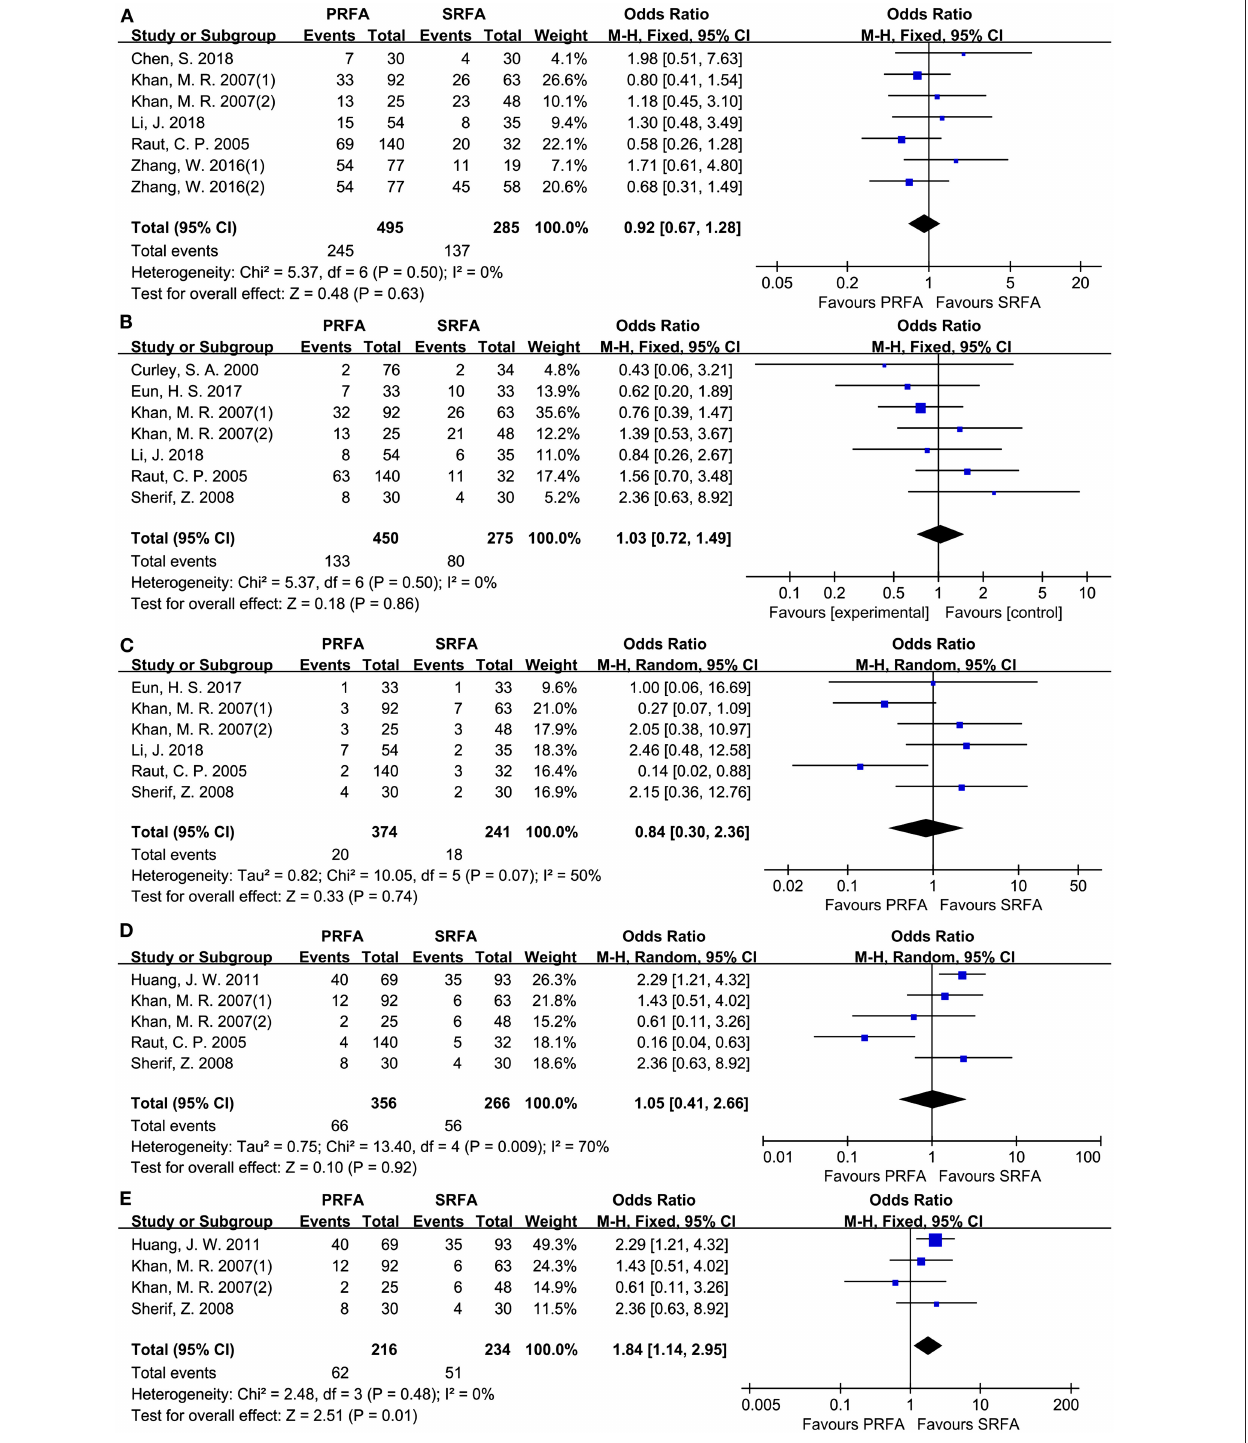
Frontiers in Surgery |